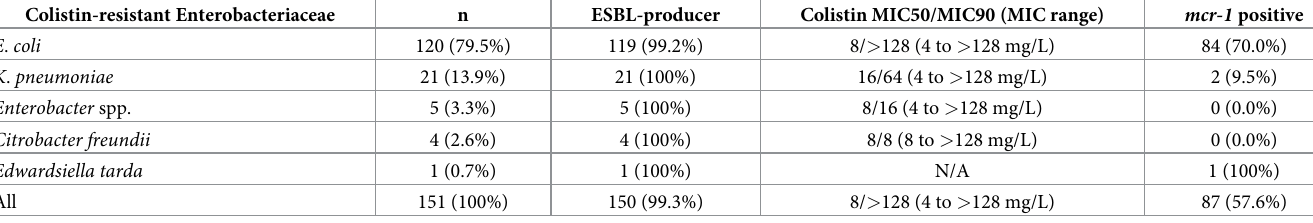
Table 3. Characteristics of all isolates of colistin-resistant Enterobacteriaceae from all study pigs. Colistin-resistant Enterobacteriaceae n ESBL-producer Colistin MIC50/MIC90 (MIC range) mcr-1 positive E . coli 120